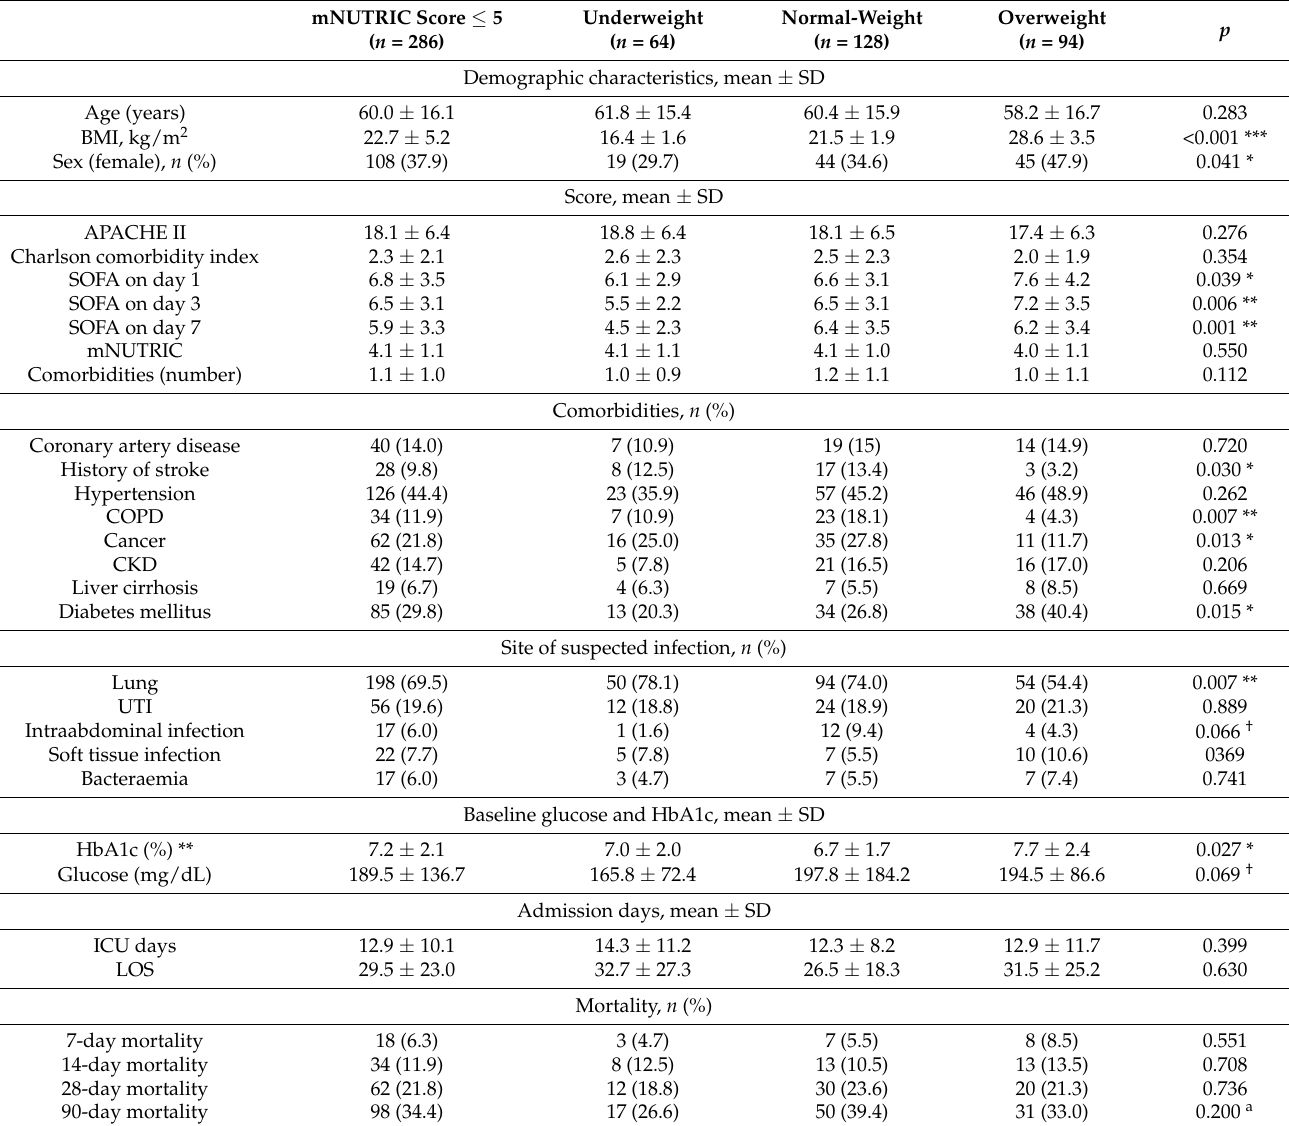
3.2%, respectively; p = 0.007) and cancer (underweight vs. normal-weight vs. overweight: 25% vs. 27.8% vs. 11.7%, p = 0.013), and the lowest mean HbA1c level (underweight vs. normal-weight vs. overweight: 7.0 ± 2.0 vs. 6.7 ± 1.7 vs. 7.7 ± 2.4, respectively; p = 0.027). In contrast, in the validation cohort group, there were higher proportions of patients with comorbidities, such as coronary artery disease and hypertension, in the overweight group with low mNUTRIC scores (Supplementary Table S2). Table 3. Baseline characteristics and outcomes of patients with sepsis who had low modified NUTRIC scores. mNUTRIC Score ≤ 5 Underweight Normal-Weight Overweight p ( n = 286) ( n = 64) ( n = 128) ( n = 94) Demographic characteristics, mean ± SD Age (years)